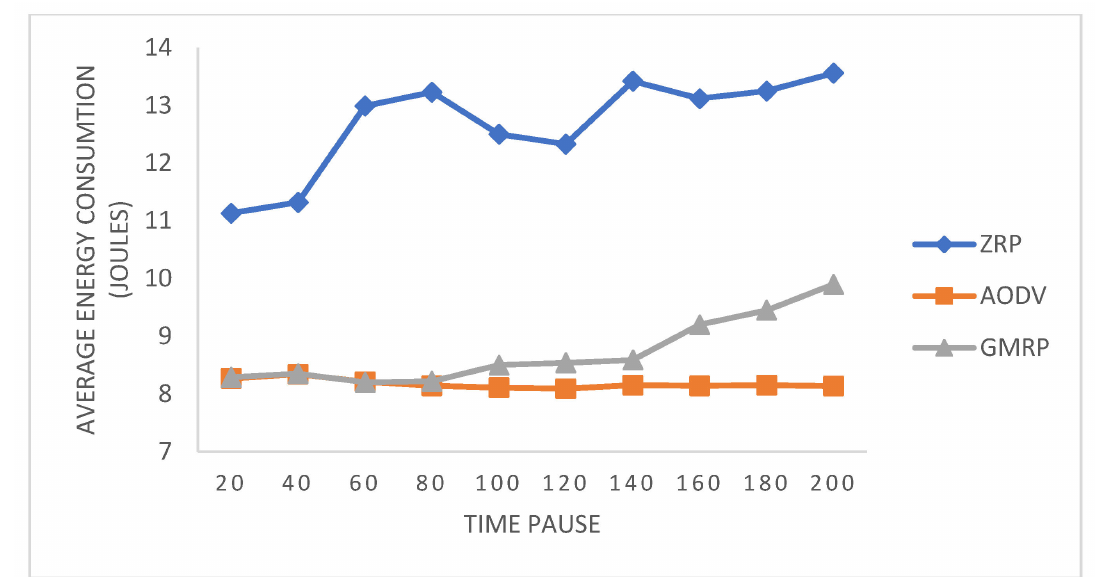
Figure 17. Average energy consumption